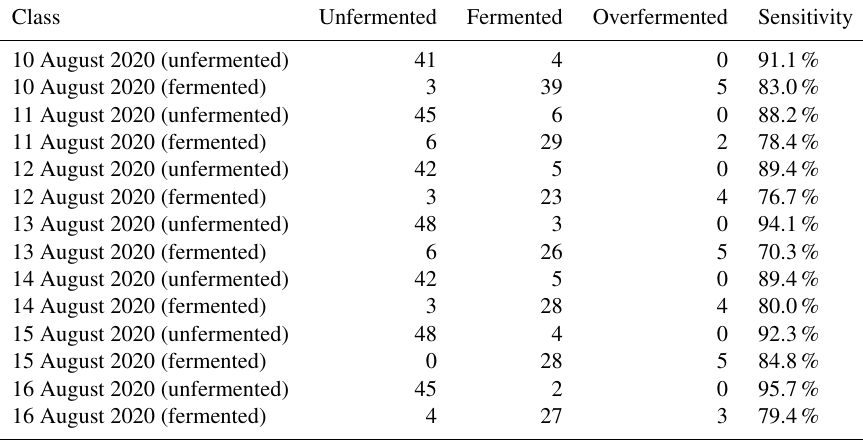
Table 2. Confusion matrix of RBM-TeaNet model during the fermentation of tea. Class Unfermented Fermented